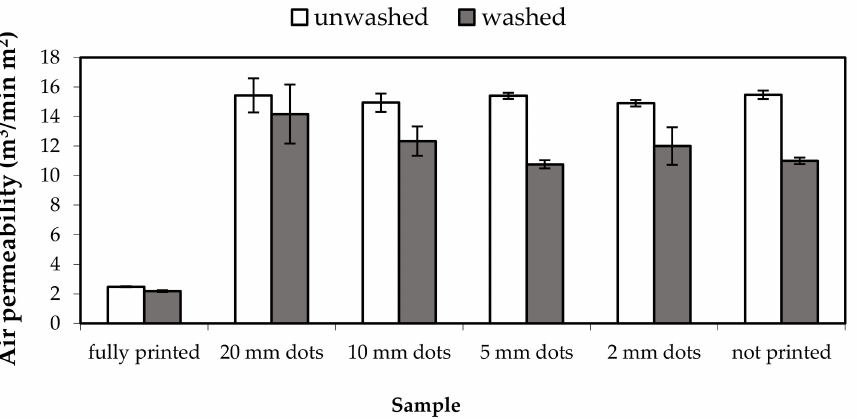
Figure 7. Air permeability of samples printed without pattern, printed by pattern (dots) and of not printed